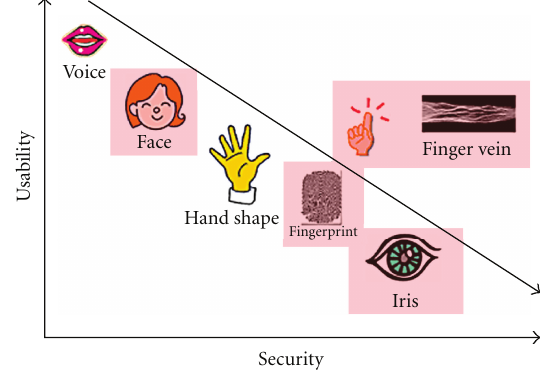
Figure 7: A simple comparison of biometric features with high- lighted features proposed for future use in passports (source: